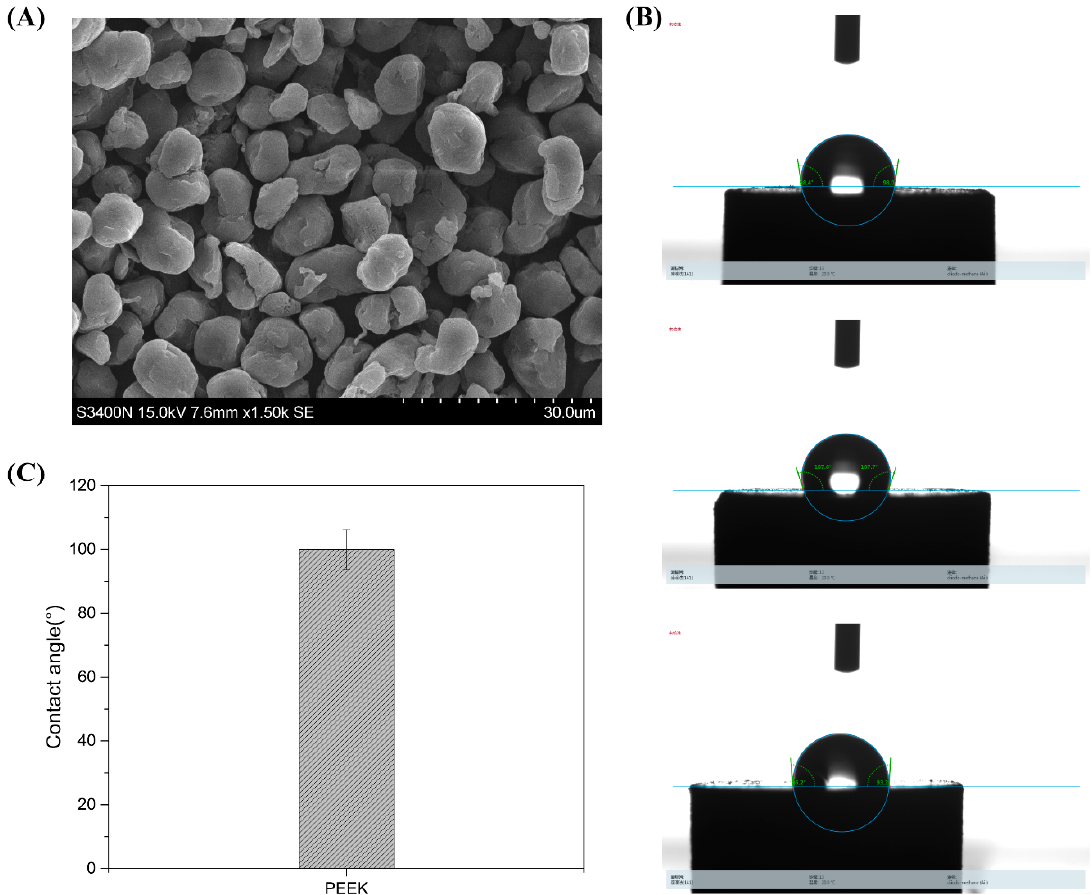
Figure 2. Characterizations of PEEK micro-particles using SEM ( A ) and contact angle test ( B , C ).